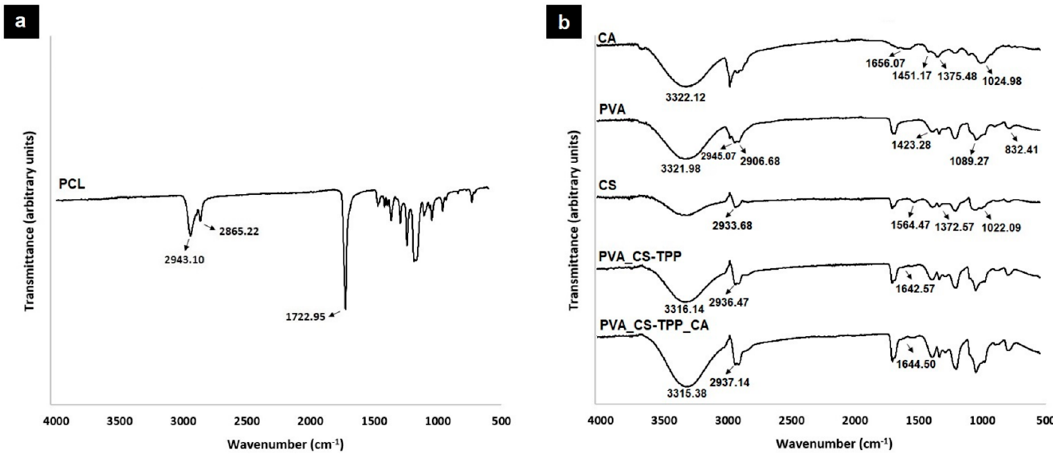
Figure 2. ATR-FTIR analysis of the produced double-layered membranes. FTIR spectra of the PCL’s top layer ( a ), the bottom layers of PVA_CS-TPP and PVA_CS-TPP_CA, and their raw materials ( b ).